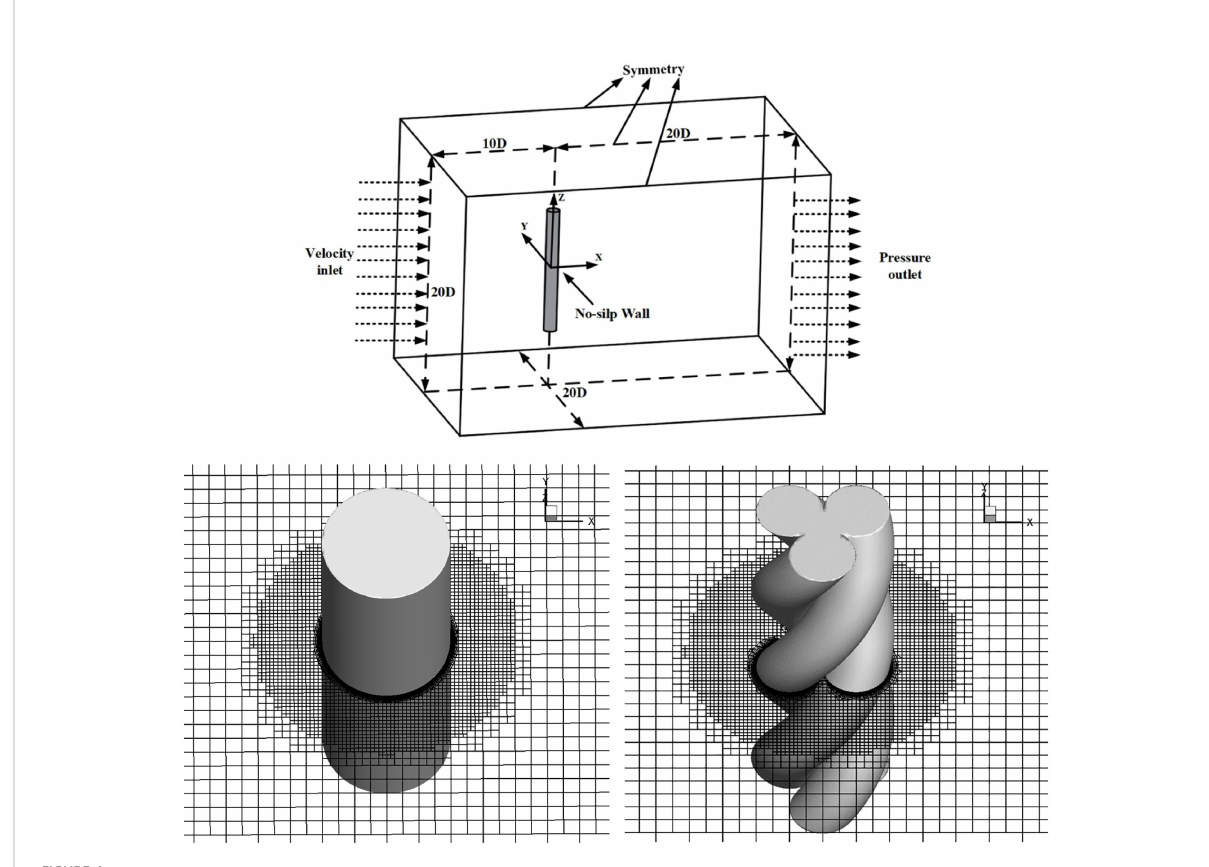
FIGURE 4 Computational domain and the prism layers for circular and twisted cylinders.